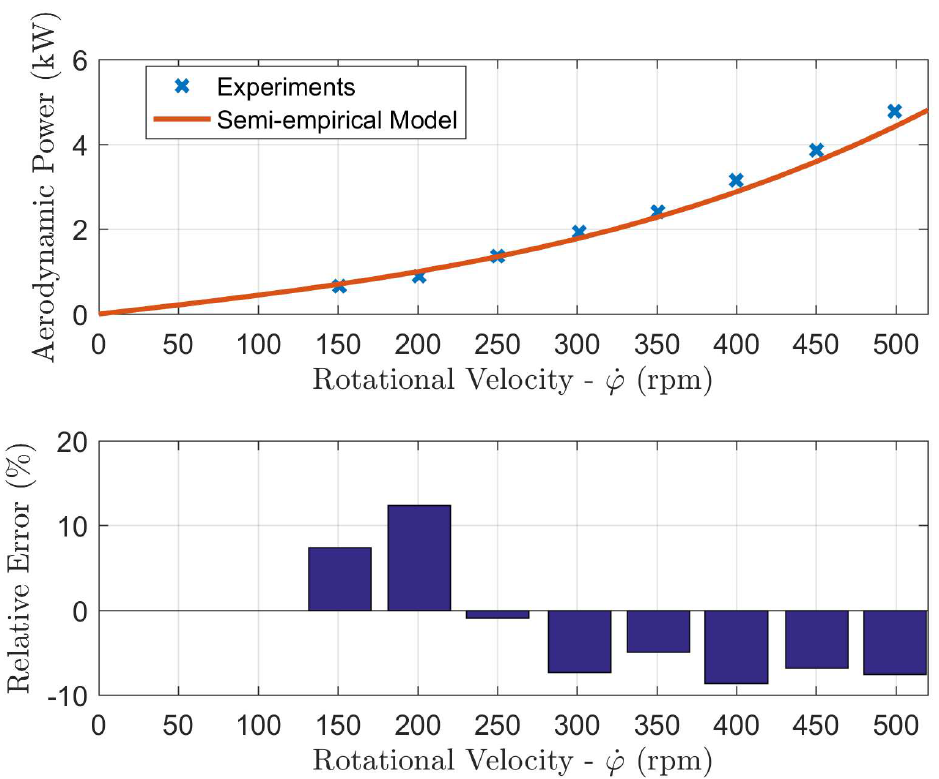
Figure 14. Aerodynamic power: experiments vs. semi-empiric model. Free